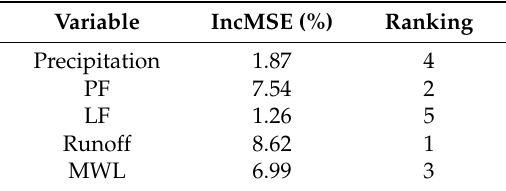
Table 4. VI of precipitation, runoff, PF, LF, and MWL to the sediment load change. Variable IncMSE (%)